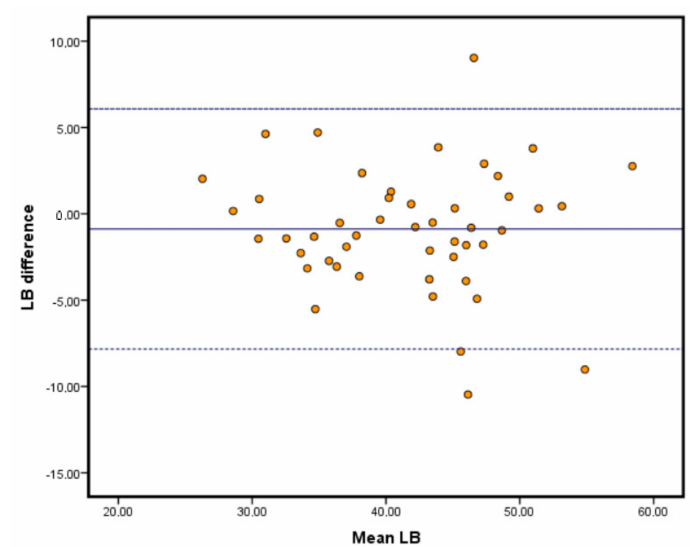
Figure A4. Bland-Altman plot left bending.